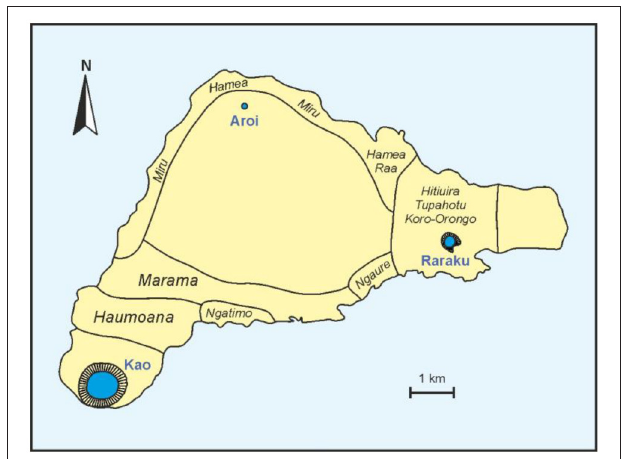
FIGURE 3 | Sketch-map of Easter Island showing the clans of the ancient Rapanui civilization. Redrawn from Routledge (1919).